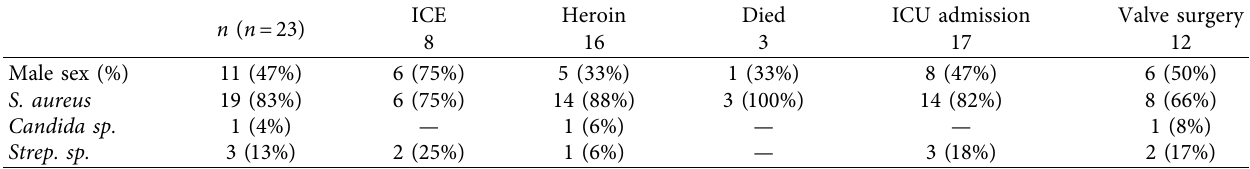
Table 2: Characteristics of patients with